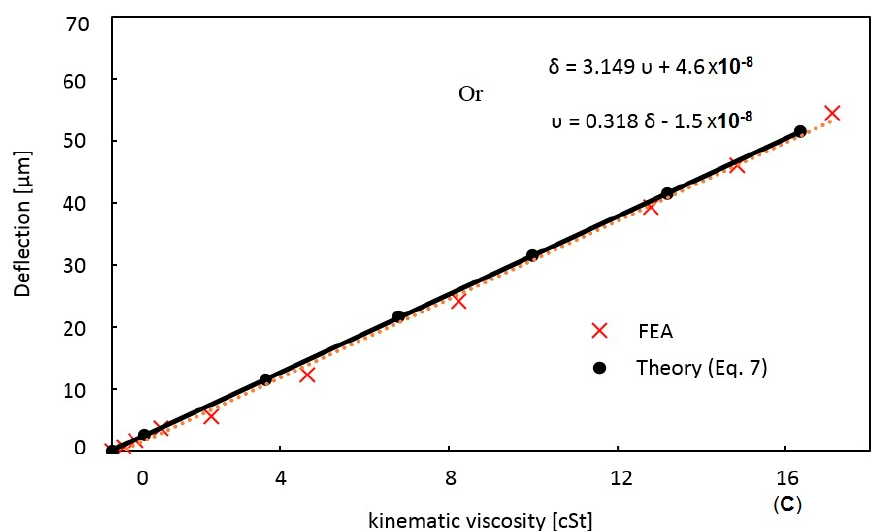
Figure 5. Finite element analysis results of microcantilever deflection when fluid density or viscosity was changed, ( a ) against density at constant viscosity, μ = 0.89 cP, ( b ) against viscosity at constant density, ρ = 997 kg/m 3 , ( c ) finite element analysis (FEA) and theoretical results of microcantilever deflection against kinematic viscosity.